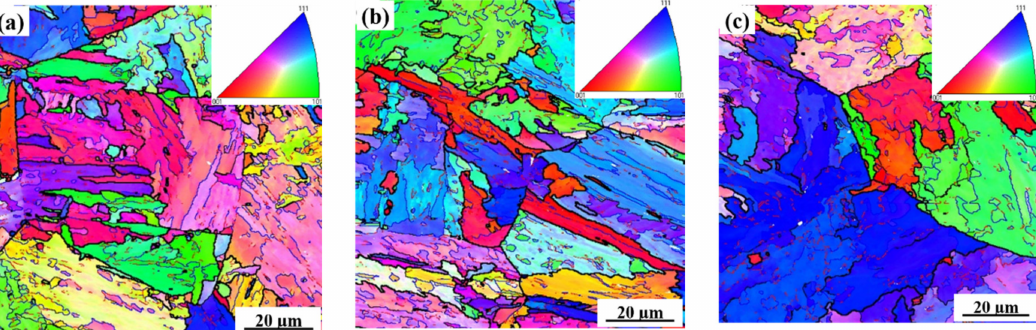
Figure 5. Orientation maps of α phase in normal direction of microstructure in the CGHAZ containing 0.14% Nb at varying heat inputs (kJ/cm). ( a ) 20, ( b ) 100, ( c ) 200.